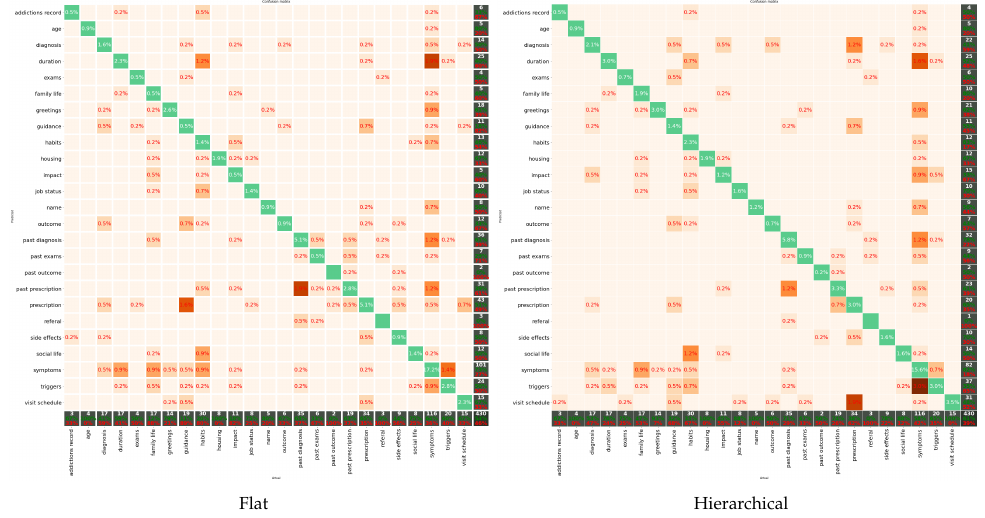
Figure 3. Confusion matrices of the flat ( left ) and hierarchical ( right ) classifiers. Reprinted with permission from [14]. Copyright 2021 Association for Computing Machinery (ACM).